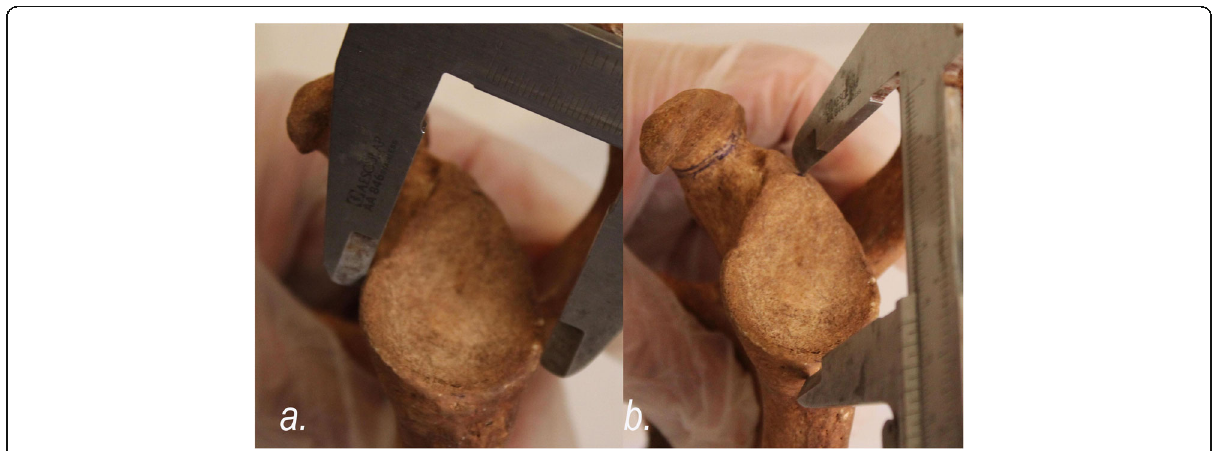
Fig. 1 The glenoid maximum ( a ) anterior-posterior (glenoid width - GW) and ( b ) the superior-inferior dimension (glenoid height - GH) are